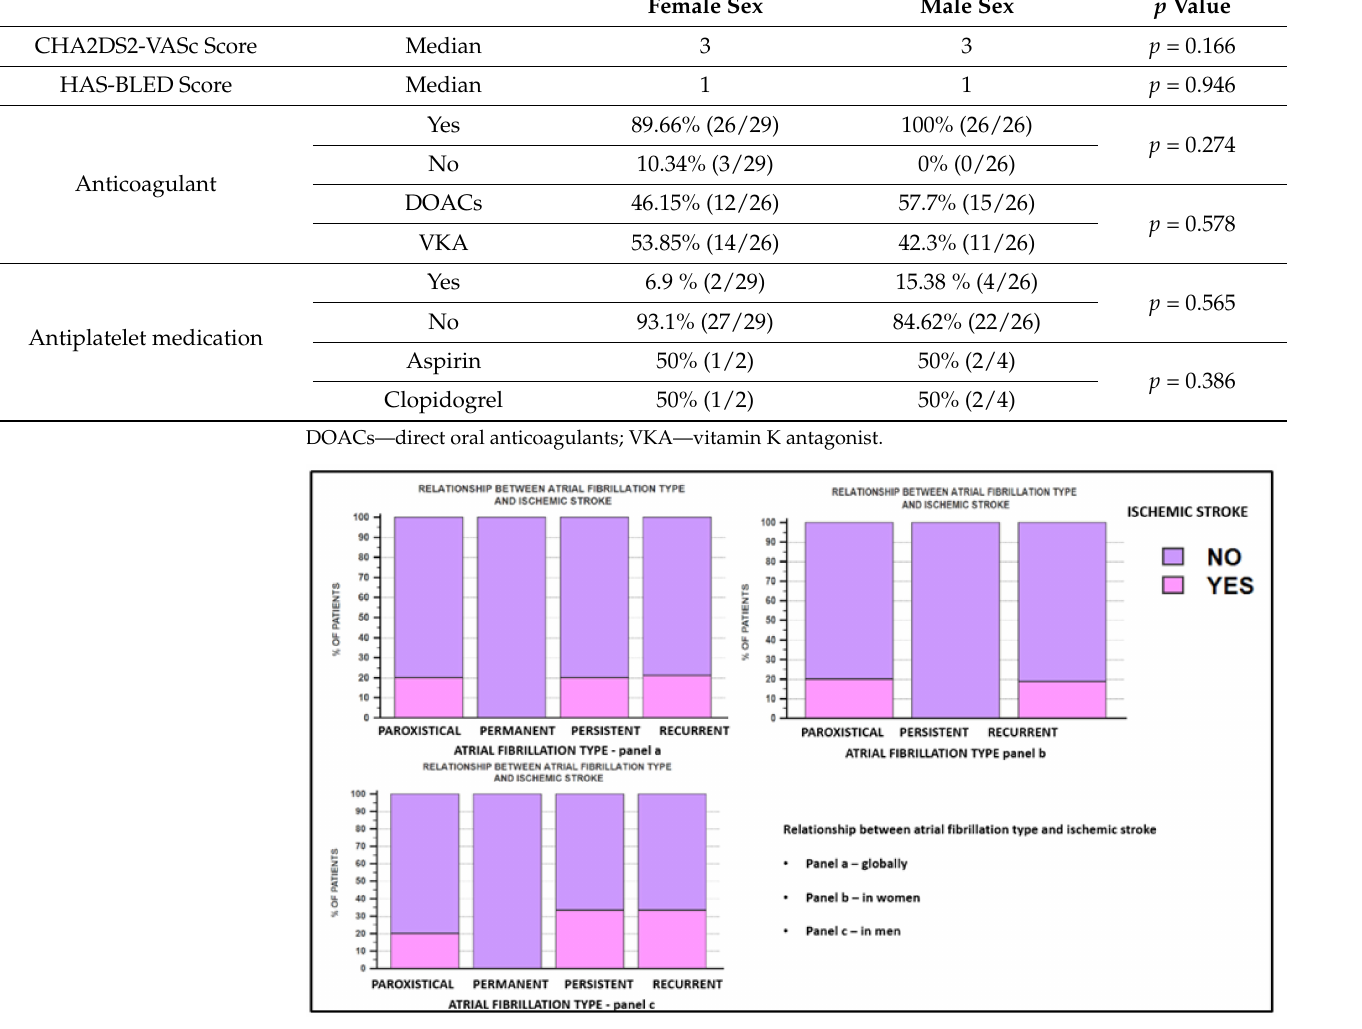
Figure 1. The relationship between the type of atrial fibrillation and ischemic stroke. In panel ( a ), the correlation between the 4 types of atrial fibrillation and the presence of ischemic stroke in the global study population is illustrated, and in panels ( b , c ) the correlation among female and male patients,